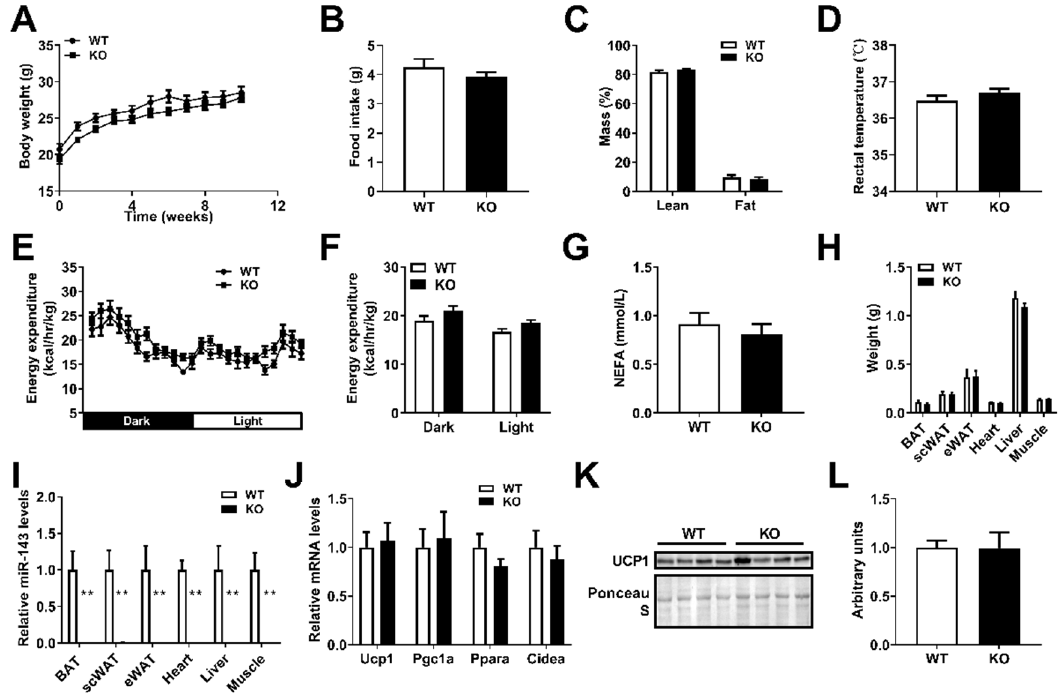
Figure 3. miR-143KO does not affect the phenotype related to energy metabolism in mice. ( A ) The body weight of WT and KO mice fed ND (n = 10). ( B – D ) Food intake ( B ), fat mass ( C ), and rectal temperature ( D ) of WT and KO mice fed ND (n = 10). ( E , F ) The energy expenditure of 8-week-old WT and KO mice fed ND for 10 weeks (n = 4). ( G ) The NEFA levels in the serum of 8-week-old WT and KO mice fed ND for 10 weeks. ( H ) The organ weights of WT and KO mice (n = 10). ( I ) The miR-143 expression in adipose tissue, heart, liver, and muscle (n = 8). ( J – L ) The thermogenic-related genes mRNA expression levels (n = 8) and UCP1 protein expression levels in the BAT of WT and KO mice fed ND. Data are presented as the mean ± SEM. ** p < 0.01 vs. controls. Two-tailed unpaired Student’s t -test.